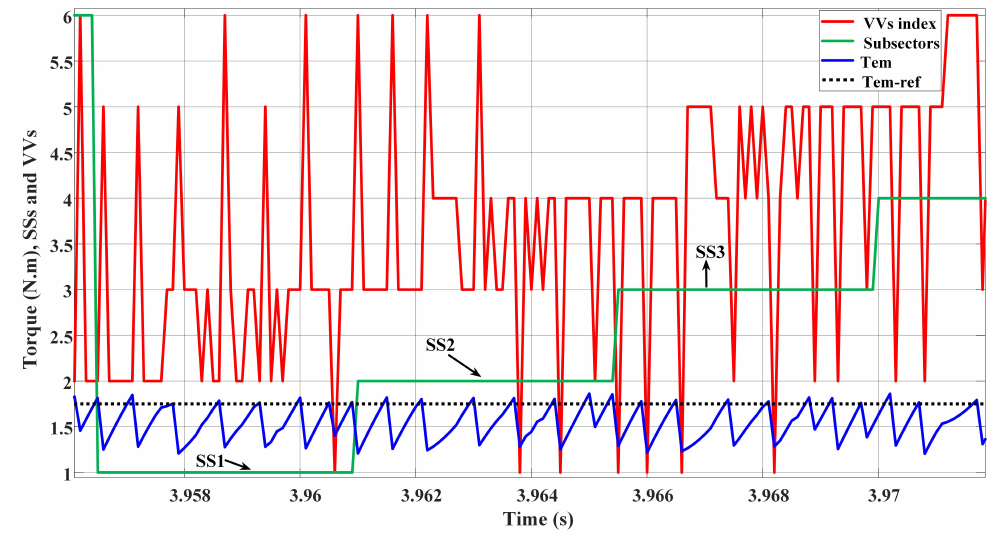
Figure 23. Torque response and applied voltage vectors of (18 SS) DTRFC strategy at high speed. It is necessary to plot the switching frequency variations of inverter power transistors over the entire speed range since, unlike the FOC algorithm, the DTRFC algorithm operates with variable switching frequency. Figure 24 shows the switching frequency variations for the three strategies, 6-sector DTRFC, 18-SS DTRFC, and the combined algorithm, from zero speed to the nominal speed.